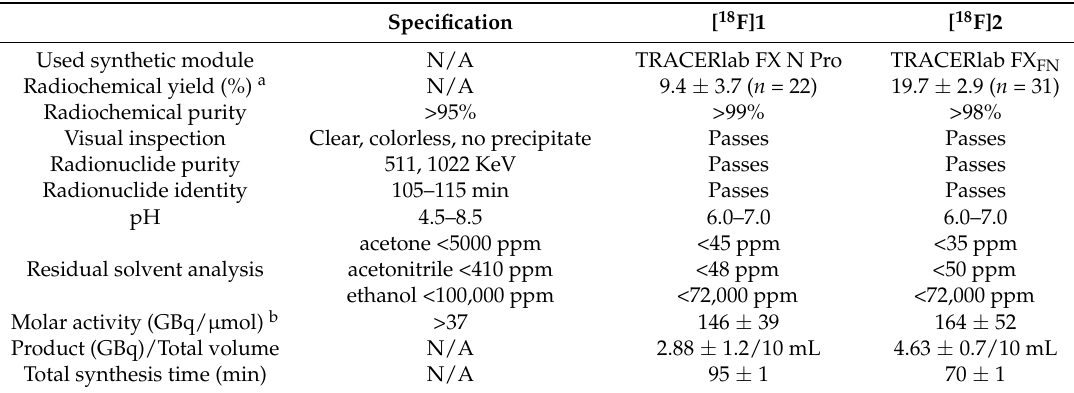
Table 1. Synopsis of the production of two TSPO radiotracers ([ 18 F]fluoromethly-PBR28 for [ 18 F] 1 and [ 18 F]CB251 for [ 18 F] 2